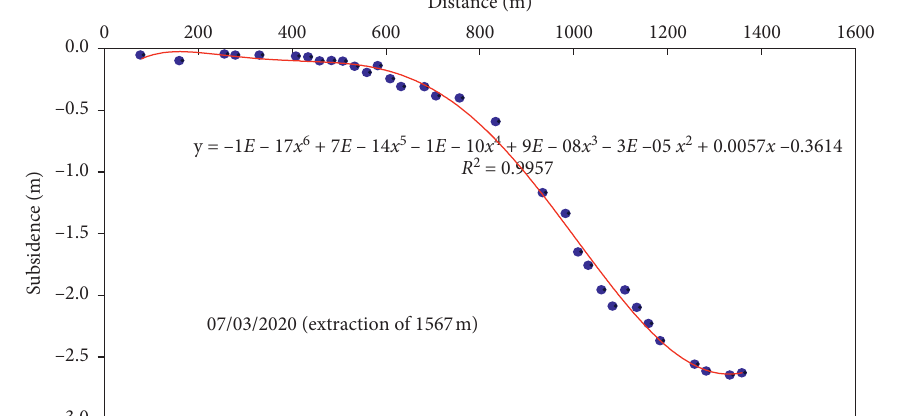
Figure 13: Subsidence value with fitted curve of point Q32.